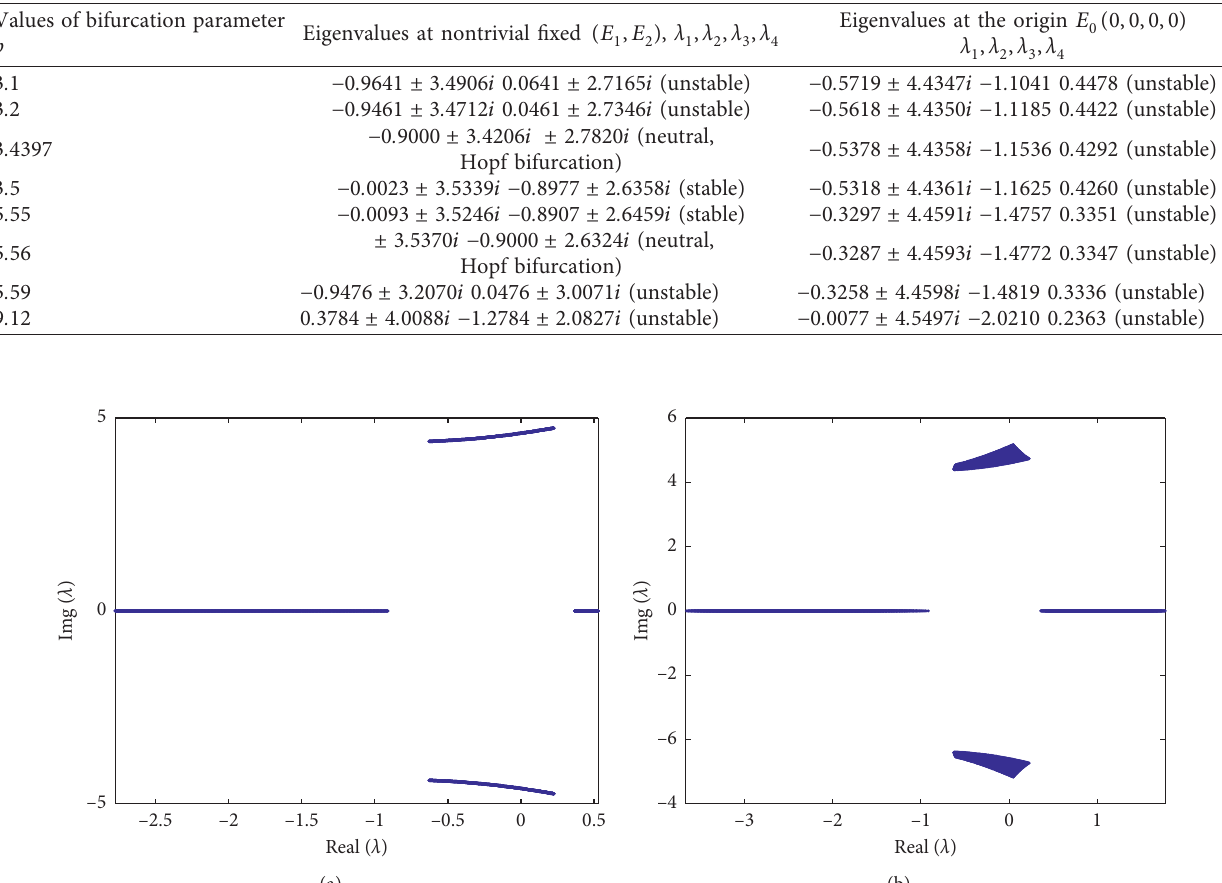
versus c and (b, c) the corresponding graphs of four largest 1